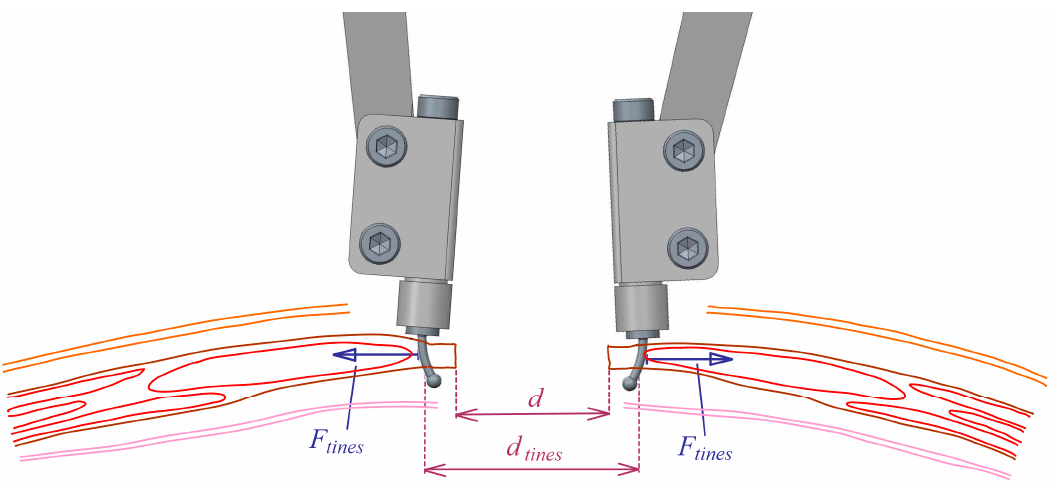
Figure 8. Distance between wound edges ( d ) and between tines of the instrument ( d tines ).